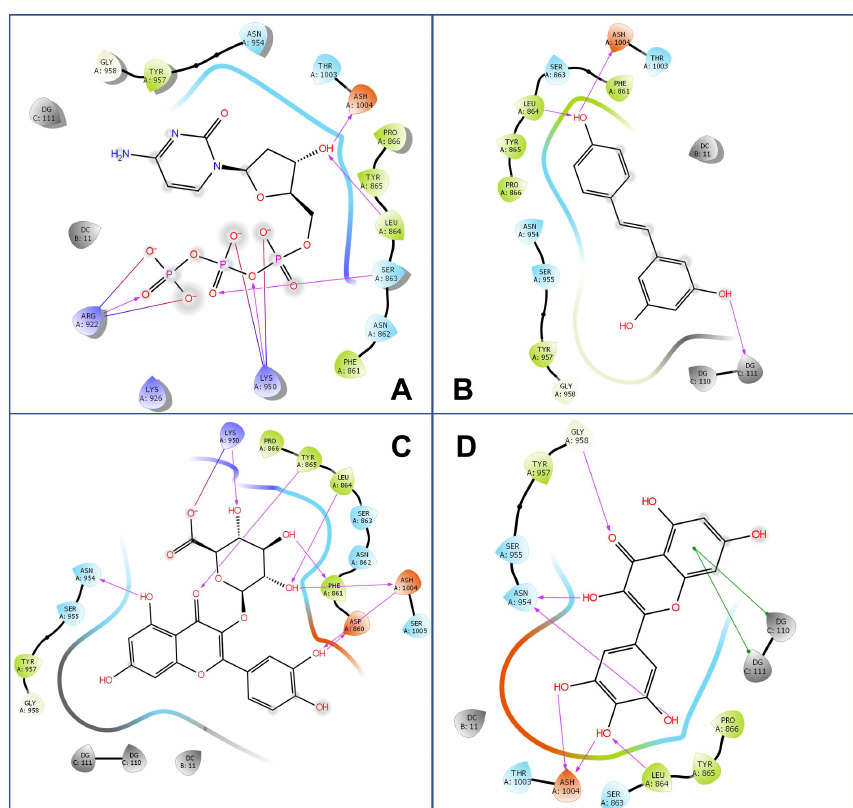
Figure 2. 2-D Protein-ligand interaction diagrams of 4Q5V and four ligands: dCTP ( A ), trans -resveratrol ( B ), miquelianin ( C ), and myricetin ( D ). The purple arrow indicates the hydrogen bond; the green line represents π - π stacking.